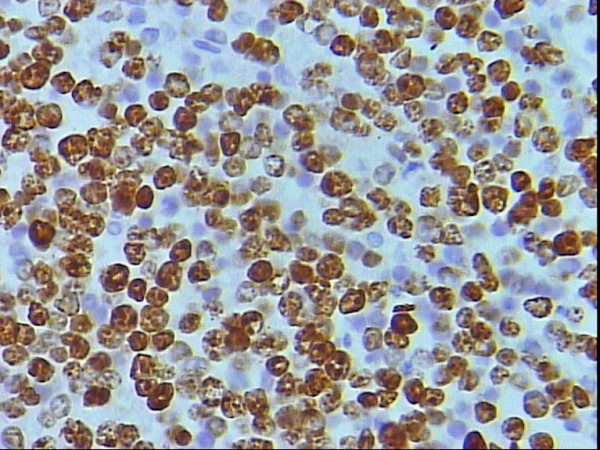
Higher power magnification of figure 9 showing strong nuclear staining of the neoplastic lymphocytes, MIB-1, DAB, Hx, × 40.